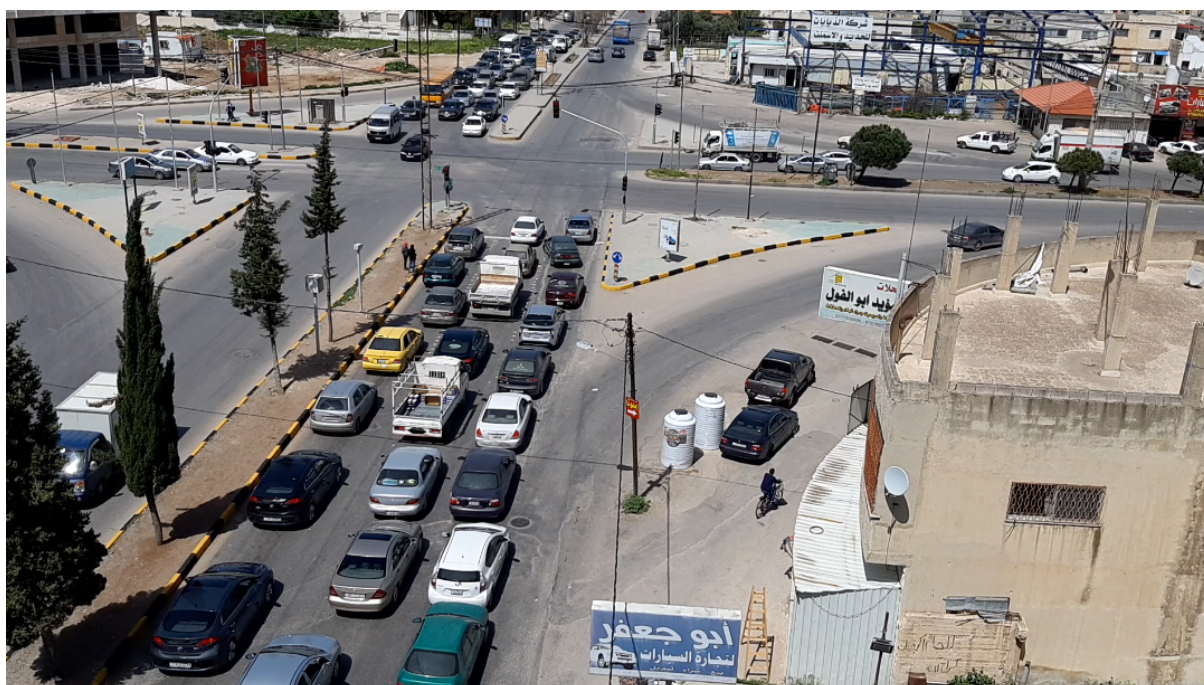
Figure 1: Aerial View for Intersection (I-3) in Irbid City.